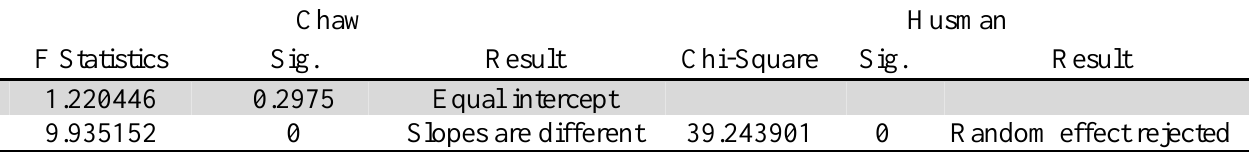
The summary of testing fixed or variable effects using Chaw or Husman tests